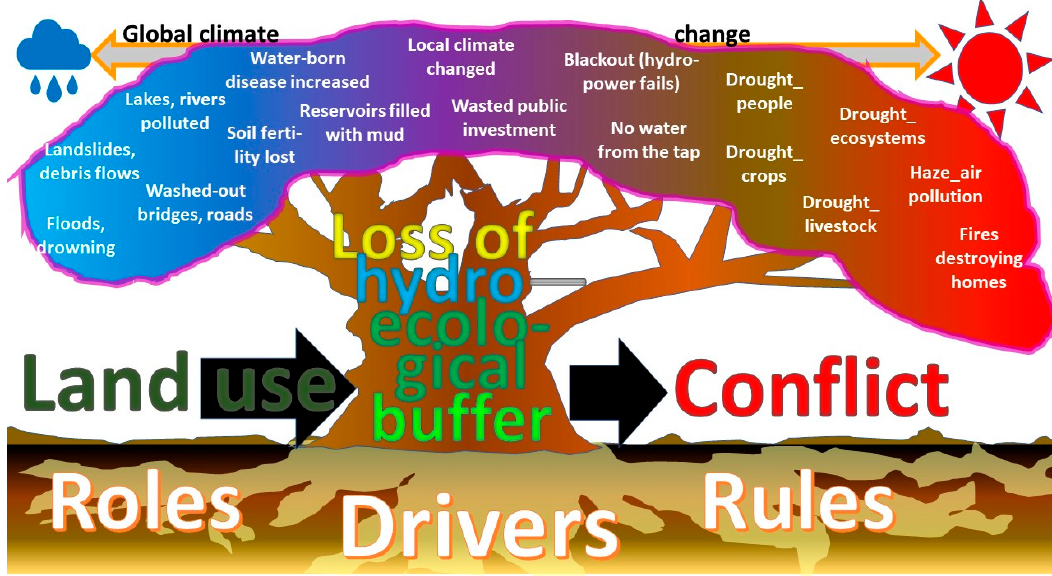
Figure 1. Problem tree of symptoms of disturbed hydrology (ranging from ‘too wet’ to ‘too dry’) and its underlying causes internal to the landscape, and external (including climate change).